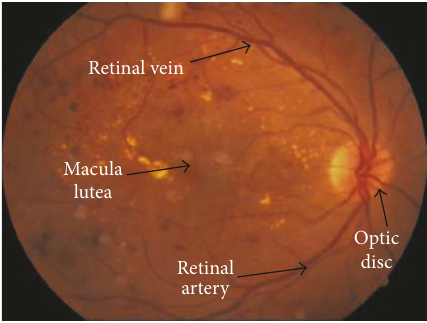
Figure 1: Retinal fundus image